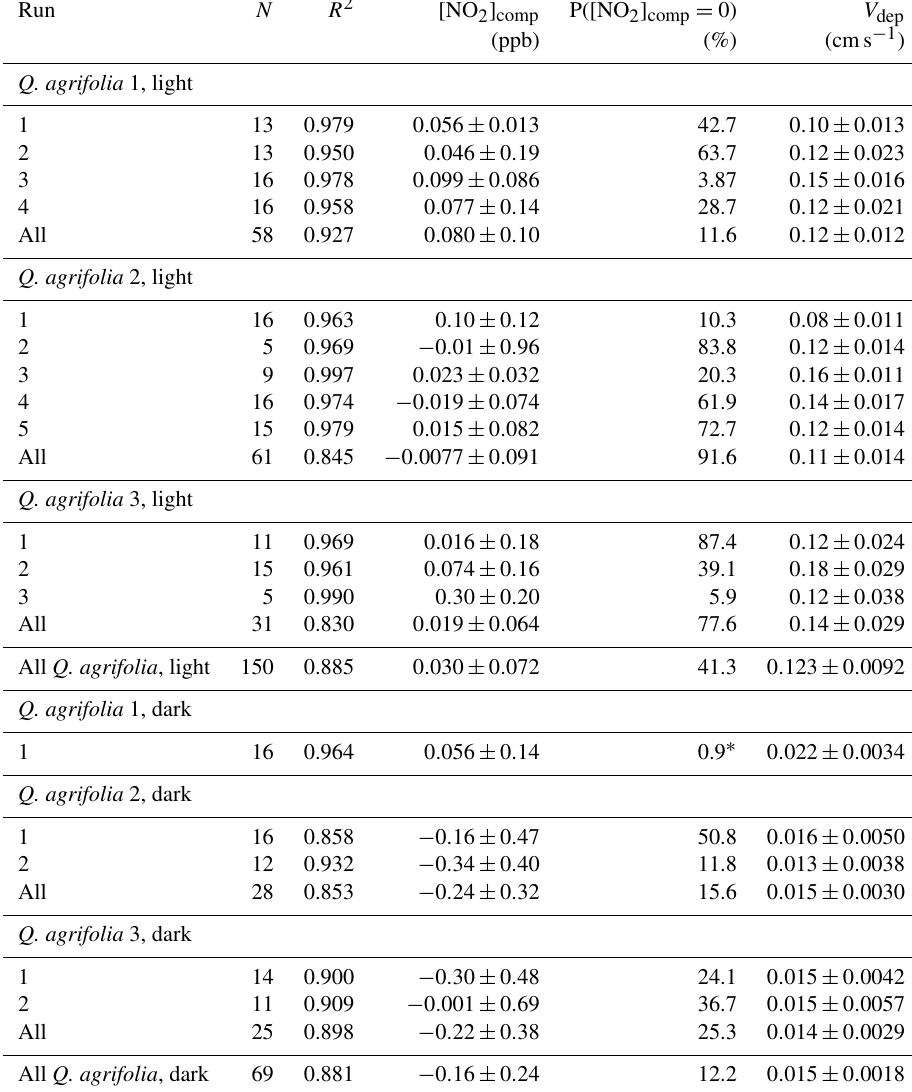
Table 1. Parameters of NO 2 bivariate linear least-square fitting regression